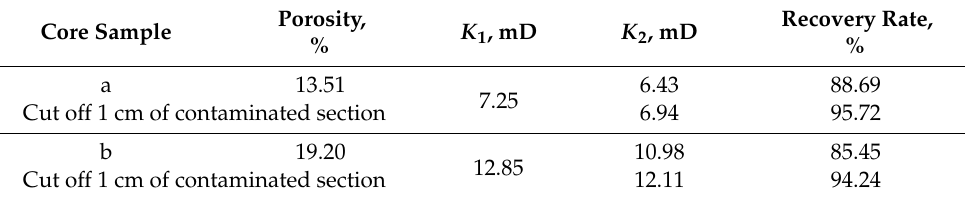
Table 6. Reservoir protection performance test for bentonite-free polymer drilling fluid. Core